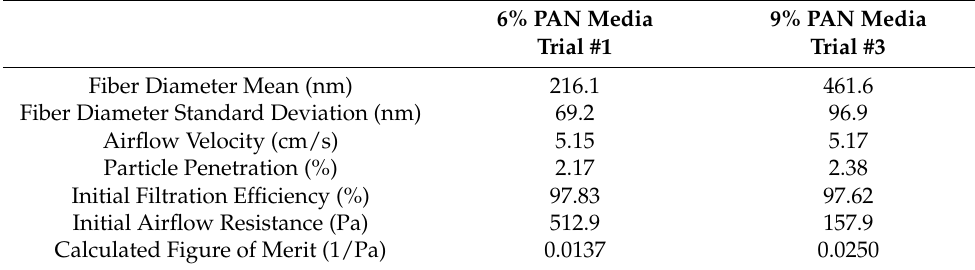
Table 3. Air filtration testing